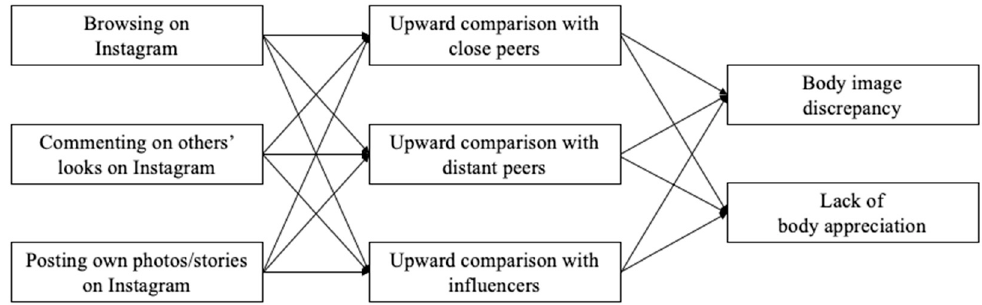
Figure 1. Hypothesized mediation model, all relationships are expected to be